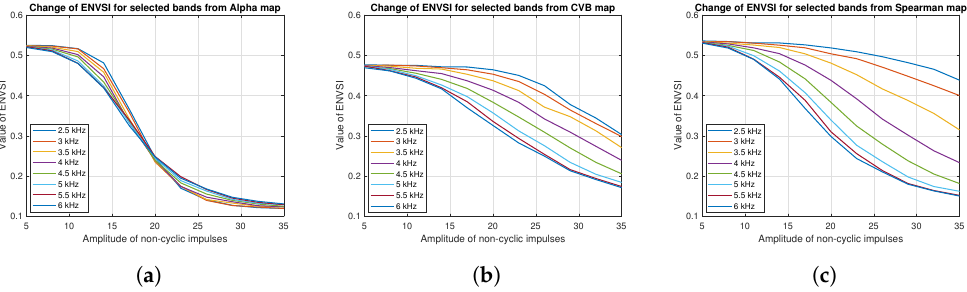
Figure 52. Change of ENVSI for selected frequency bands for the three considered methods: ( a ) Alpha selector, ( b ) CVB selector, ( c ) Spearman selector